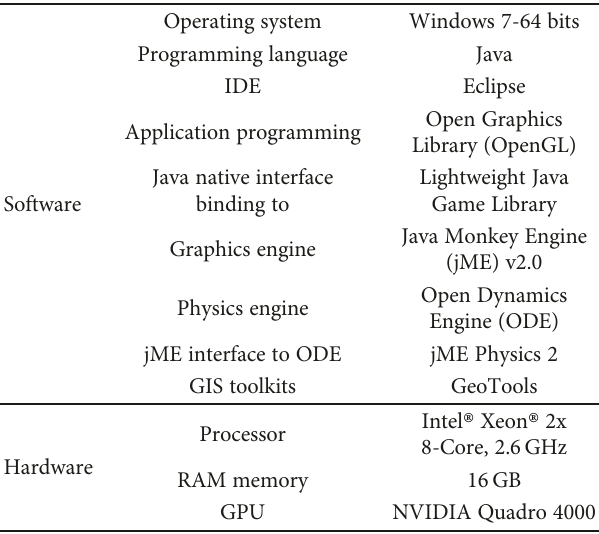
Table 4: Software and hardware